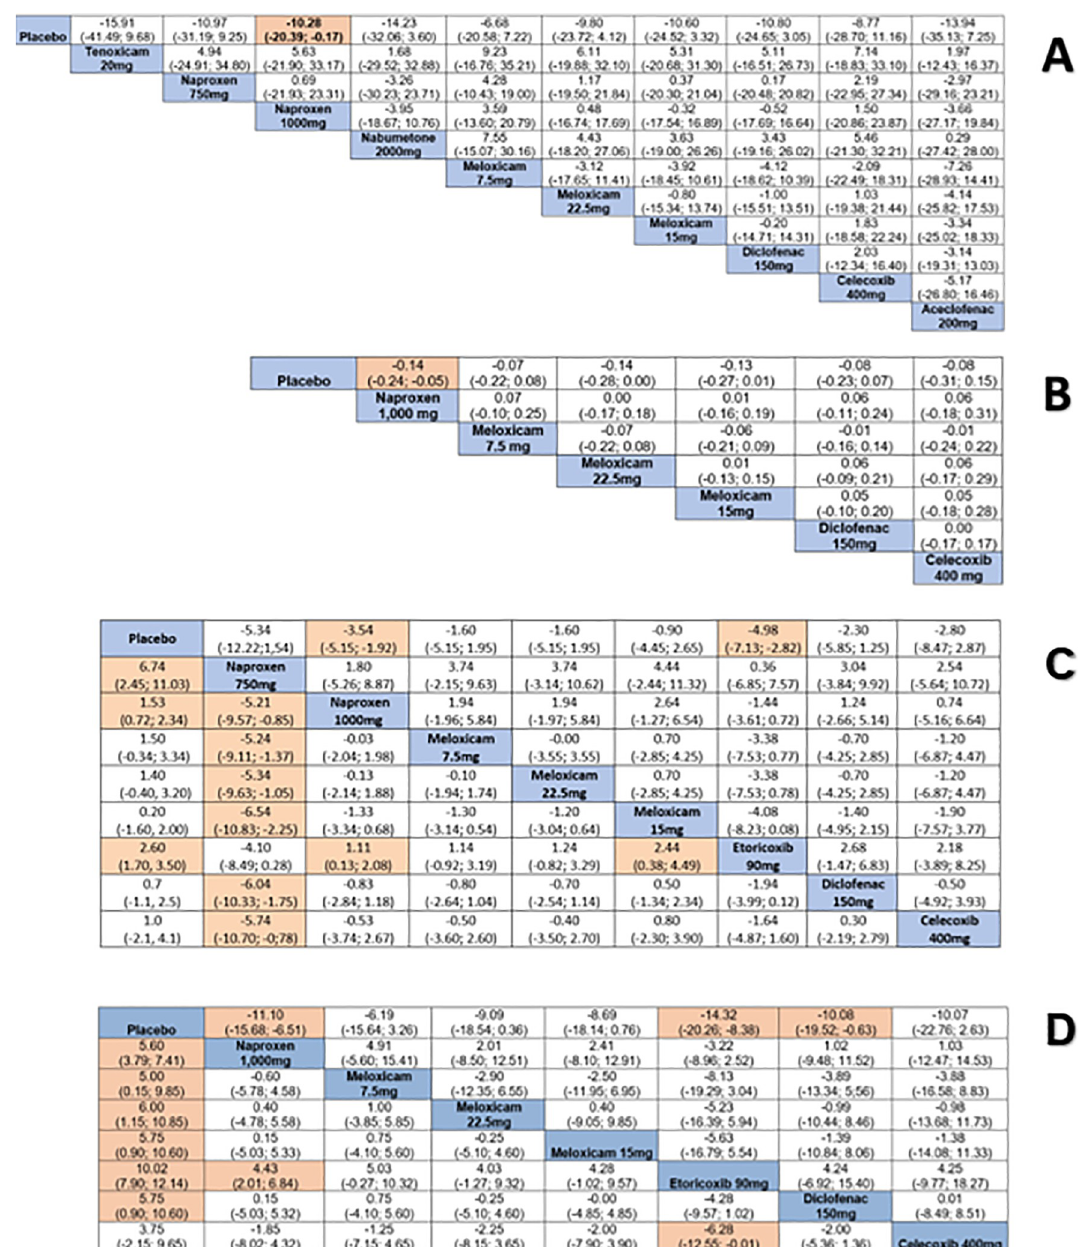
Fig 4. Comparative effectiveness outcomes between drugs using network meta-analysis. Comparisons should be read from left to right. Standardized mean difference (SMD) for comparisons are located in the common cell between the column-defining and row- defining treatment. Numbers on highlighted background are statistically significant. A. Pain; B. Physical function; C. Number of tender/painful joints (upper right quarter) and number of swollen joints (lower left quarter); D. Patient’s global assessment (upper right quarter) and physician’s global assessment (lower left